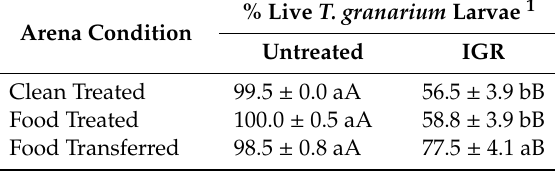
Table 7. Percentage for live T. granarium larvae (means ± SE) five days after being exposed on untreated concrete arenas clean concreate arenas treated with the pyrethrin + methoprene + piperonyl butoxide formulation (IGR) arenas in which 500 g of diet was placed in the arenas prior to treatment, or arenas in which the food was removed and placed on untreated arenas. Bioassays conducted at one day after treatment (Month 0) or after 1, 2, and 3 months post-treatment. Month not significant in overall ANOVA (Table 6), data combined for month.